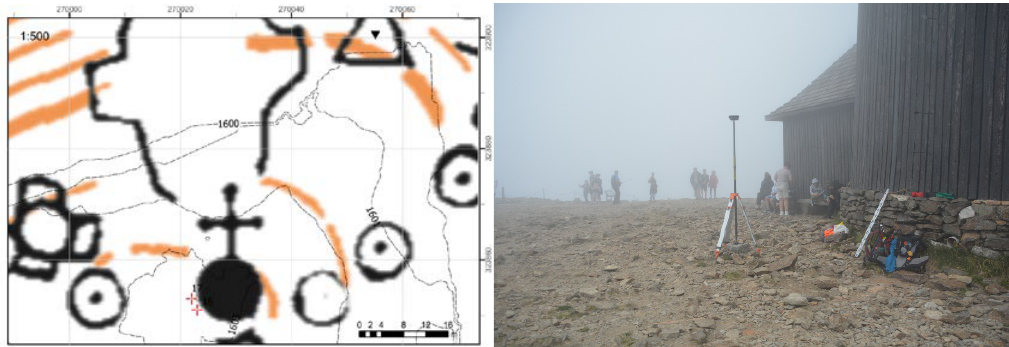
Figure 4. Points potentially considered to be the highest points of the peak (left, red crosses at the bottom of the figure) based on DEM analysis, and direct field measurement (right).